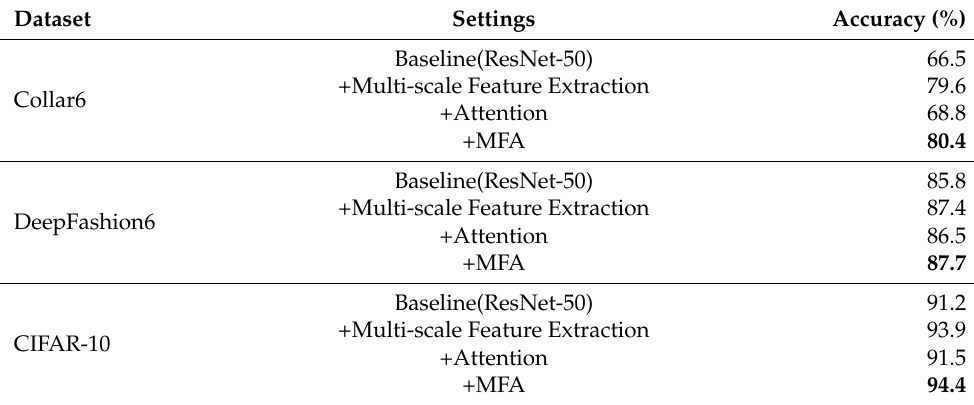
Table 9. Results of the structural ablation experiments.